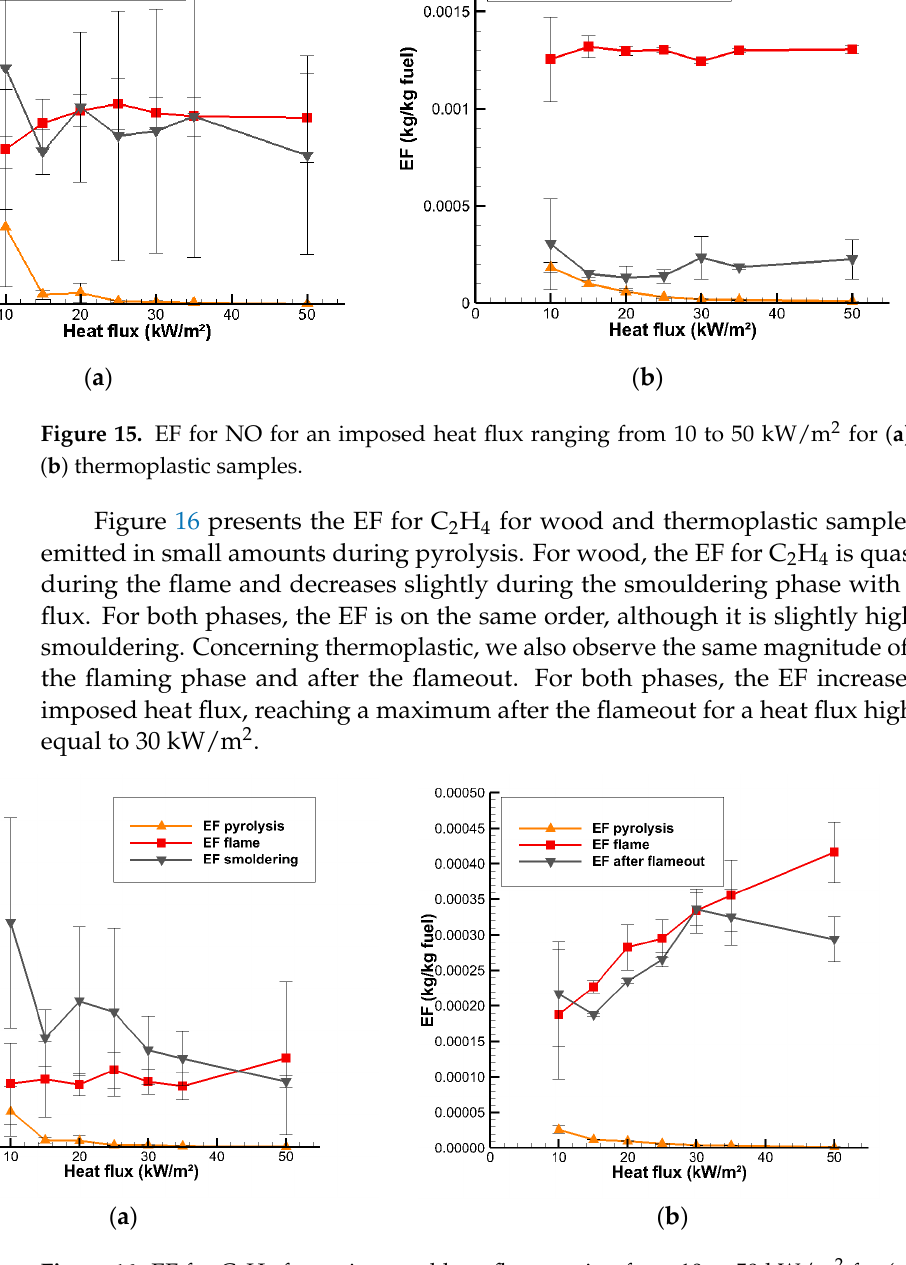
Figure 14. EF for CH 4 for an imposed heat fl ux ranging from 10 to 50 kW/m 2 for ( a ) wood and ( b ) thermoplastic samples.